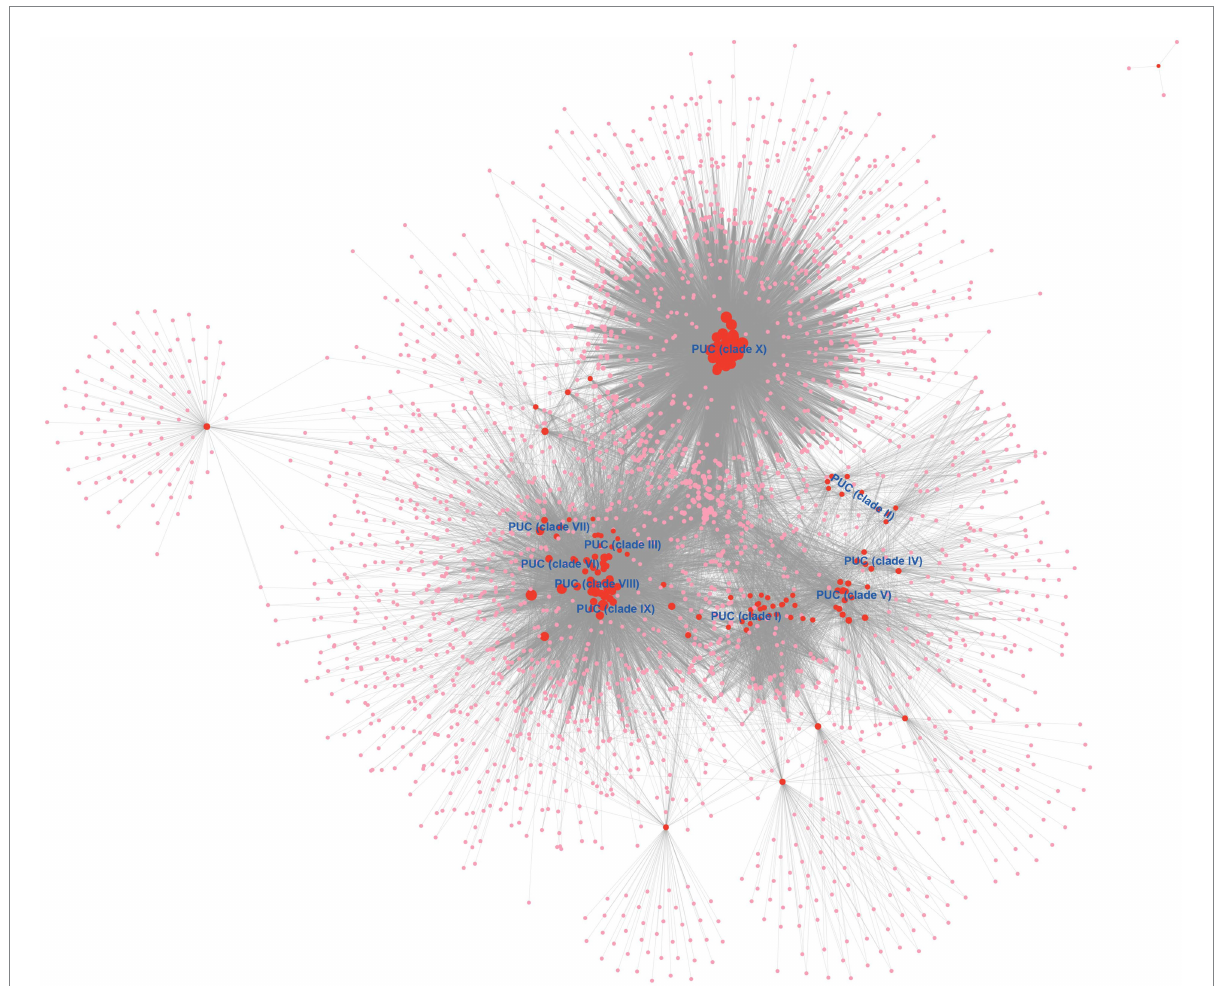
FIGURE 4 The PU-HPC bipartite network visualization of the bla NDM -harboring plasmids of K. pneumoniae . Plasmid units (PUs, 171) and homologous protein clusters (HPCs, 2,502) are represented as colored circles, with red for PUs and pink for HPCs. The size of a circle is ranked as the degree calculated with the Cytoscape’s built-in NetworkAnalyzer tool. The 10 clades (Clade I–Clade X) were labeled into the location of corresponding